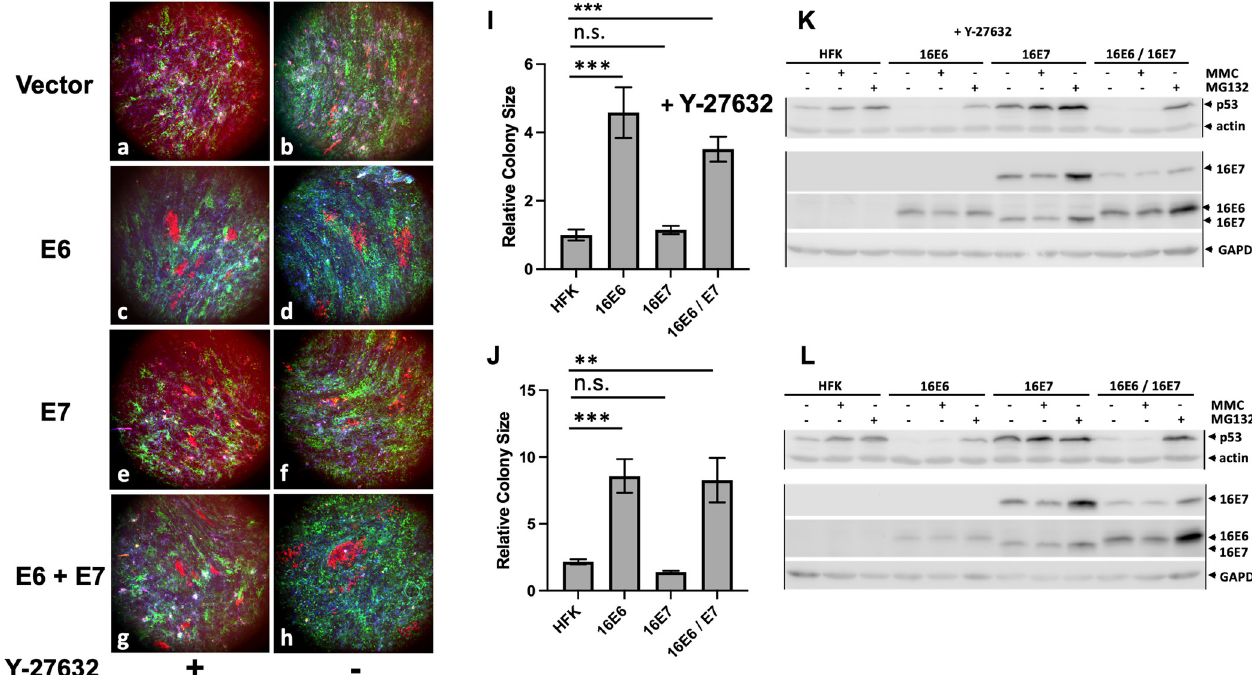
Fig 4. Cell colony competition is induced by E6 in primary keratinocytes. Primary foreskin keratinocytes maintained in the presence of the rho kinase inhibitor Y-27632 were transduced with the indicated fluorescent proteins and oncogenes and seeded onto glass coverslips as described in Fig 1. One set was maintained in media supplemented with Y-27632 (Fig 4A, 4C, 4E, 4G and 4I), but in a duplicate set Y-27632 was removed after seeding onto glass coverslips (Fig 4B, 4D, 4F, 4H, and 4I). Cells were fixed and stained with dapi on day 21 and red colony sizes ascertained by quantitation of photomicrographs in arbitrary units. Error bars represent the variation in colony sizes normalized to vector-transduced cells from 4 experiments and denote standard error of the mean. ��� is P < 0.001; �� is P < 0.0.01; n.s. is not significant. Western blots for expression of p53, actin, 16E6, 16E7, and GAPDH are shown from cells growing in the presence or absence of Y-27632 in parts Fig 4K and 4L